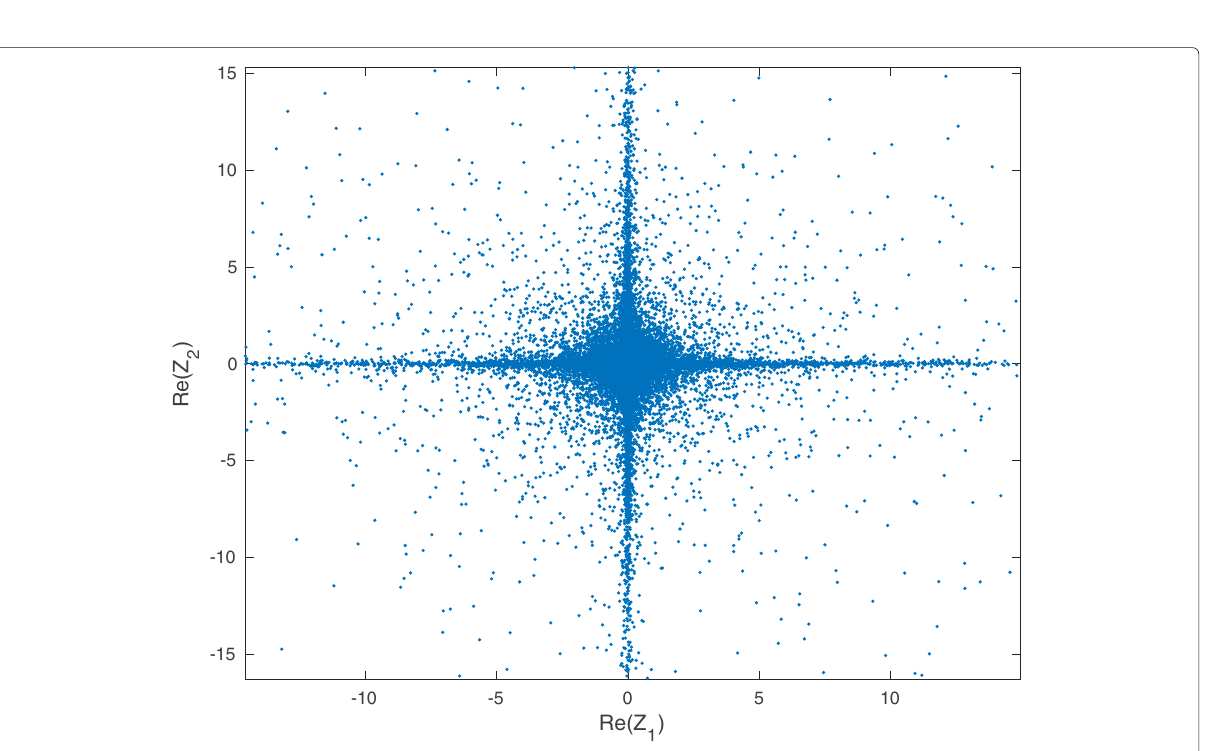
Fig. 3 Scatter plot of samples from the real parts of interference drawn from two distinct bands, b 1 , b 2 . Samples generated from a network of devices using a codebook with b 1 selected with probability 1 / 2 and b 2 selected with probability 1 / 3 if b 1 is selected and 2 / 3 if b 1 is not selected. The distribution of devices is the same as Fig.